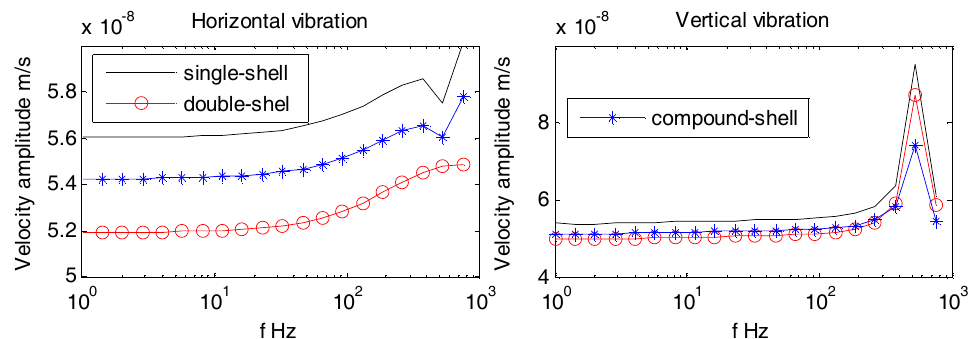
Figure 31. Vibration velocity amplitudes of the OBSs with various casings under incident angle of 60°.